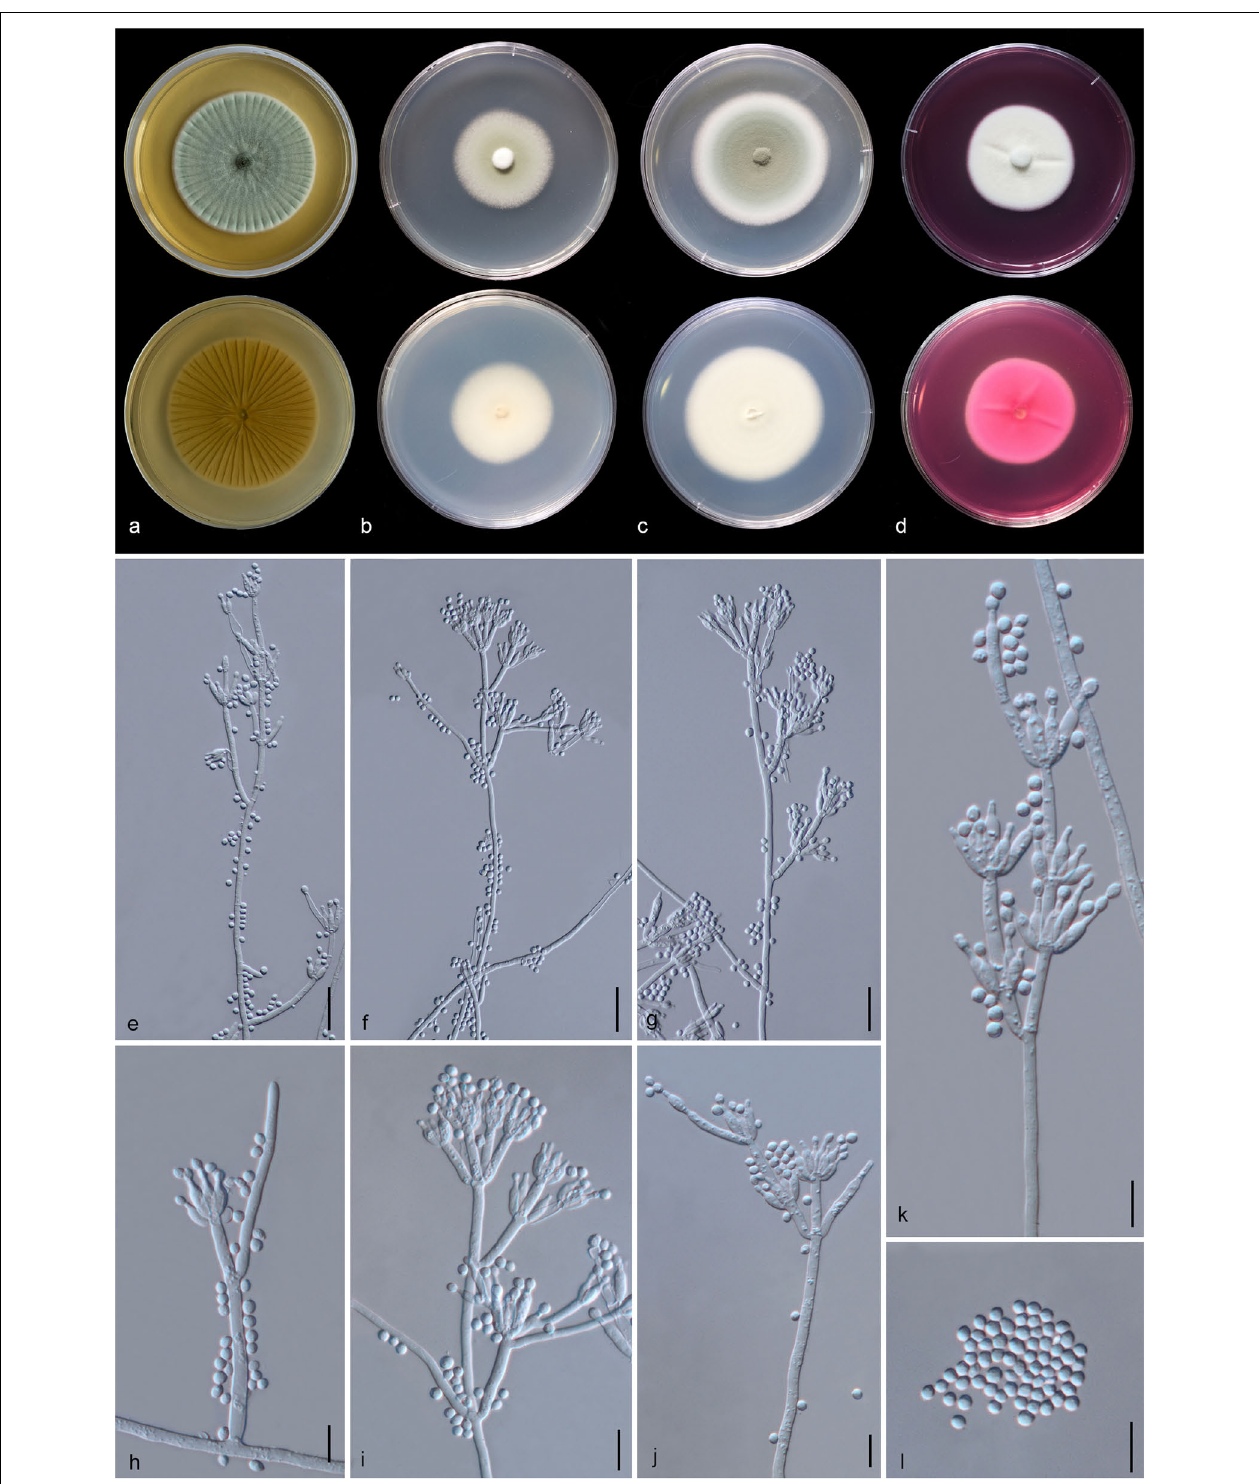
FIGURE 13 | Penicillium soli (MFLU 20-0432, holotype). (a–d) Colonies on MEA, CYA, PDA and rosebengal at 25 ◦ C, respectively. (e–g) Conidiophores and conidia. (h–k) Close-up of conidiophores and conidia. (l) Conidia. Scale bars: (e–g) = 20 µ m, (h–l) = 10 µ m.